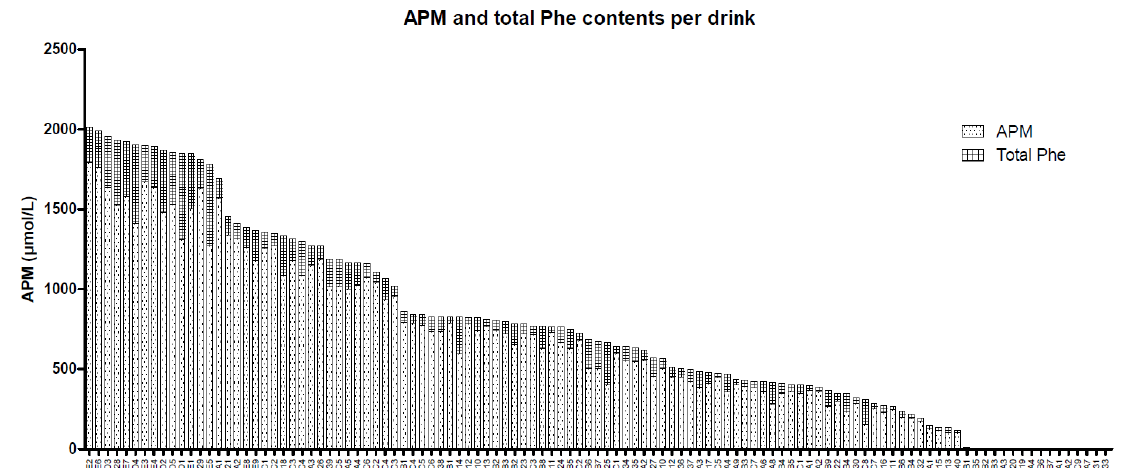
Figure 1. Aspartame and total phenylalanine contents of all 111 soft drinks. Specifics regarding the soft drinks and their countries of origin can be found in Supplementary Table S2, where the first letter indicates the group, the second letter indicates the cluster, and the number indicates the number of the soft drink. APM, aspartame, Phe, phenylalanine.